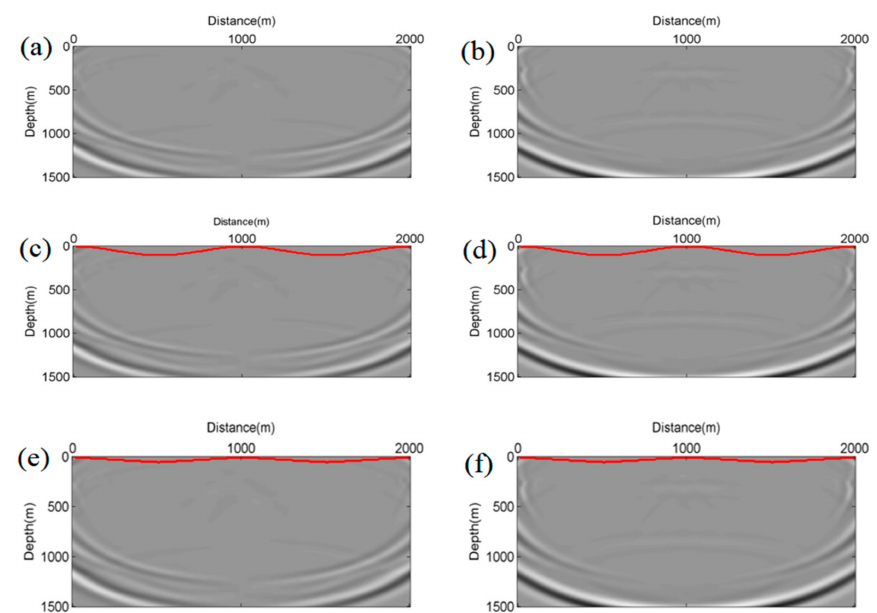
Figure 6. Forward elastic wavefield at 600 ms for graben elastic models with different topographies. The left panels are the horizontal particle velocity, and the right panels are the vertical particle velocity. Panels ( a , b ) are the forward wavefield for graben elastic model with a horizontal topography, panels ( c , d ) are the forward wavefield for graben elastic model with a sinusoidal topography, and panels ( e , f ) are the forward wavefield for graben elastic model with a triangular topography. The red line is the surface topography.